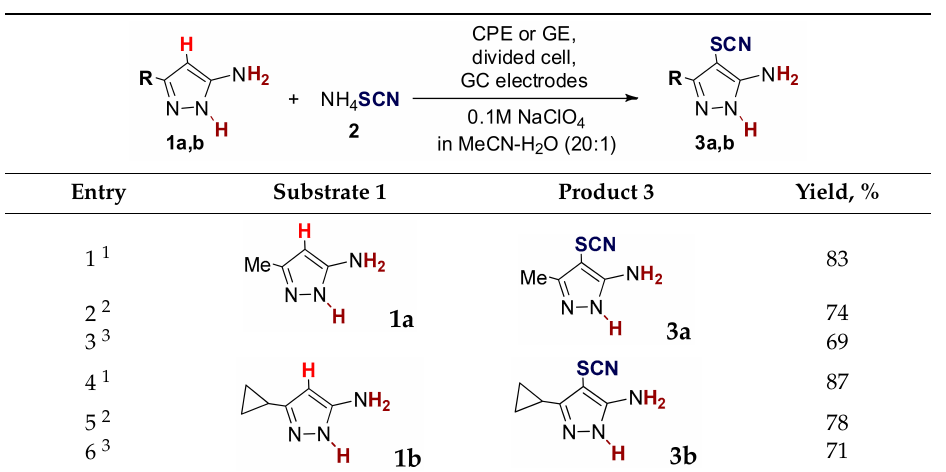
Table 2. C–H (An) thiocyanation of azoles 1a,b